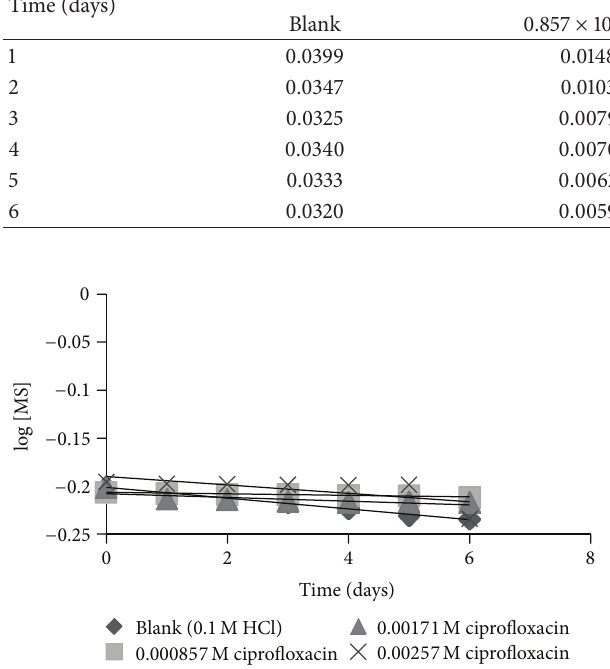
Figure 3: Linear plots of log of concentration of mild steel against time.